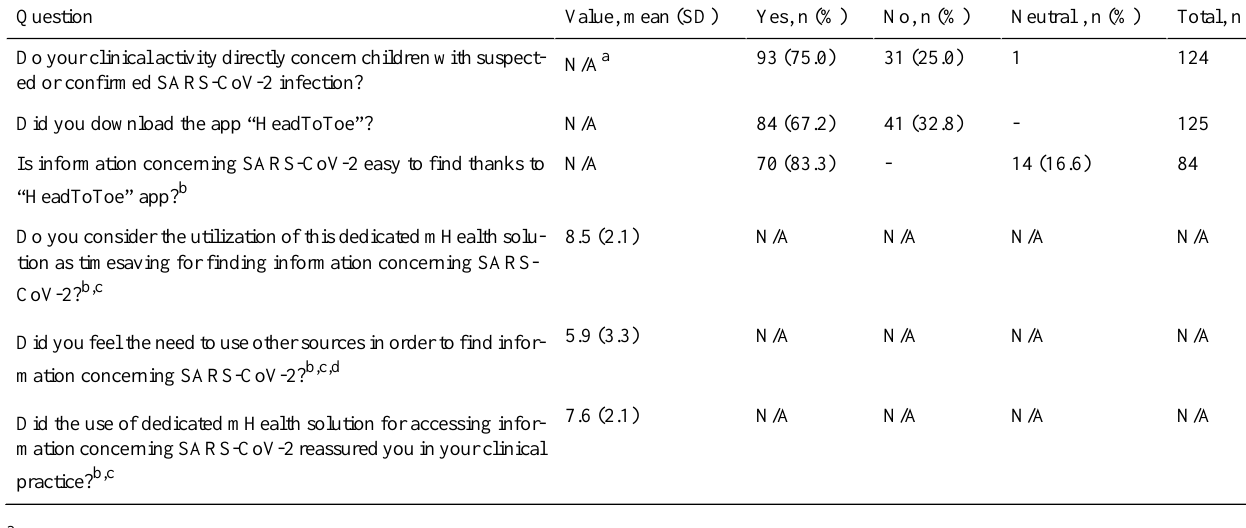
Table 3. Medical staff’s utilization of a dedicated mHealth solution for SARS-CoV-2 information